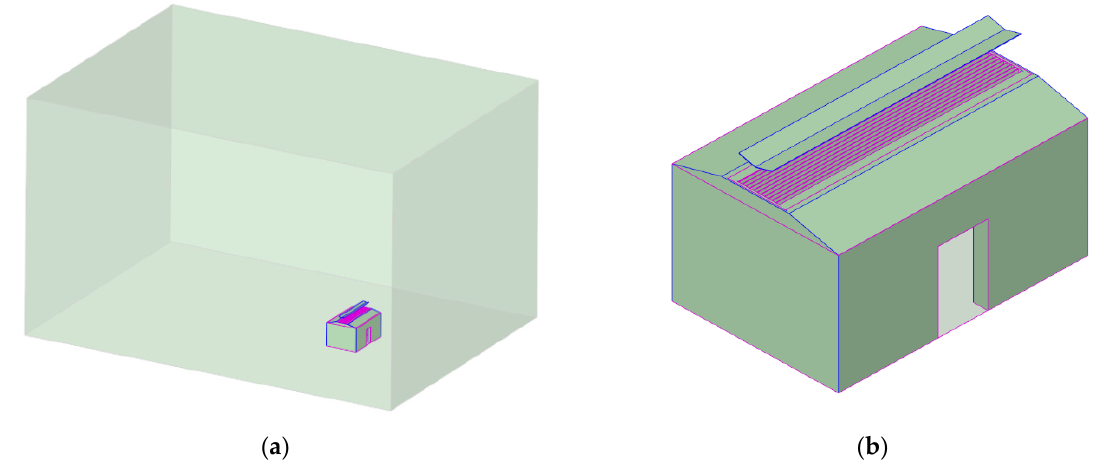
Figure 4. Numerical model constructed by computational fluid dynamics (CFD). ( a ) Complete model; ( b ) local model.